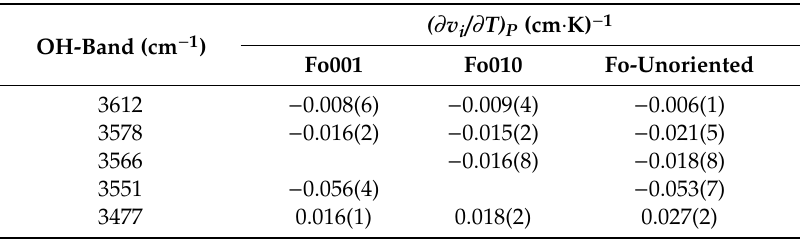
Table 1. The main OH bands with the temperature dependence ( ∂ v i / ∂ T ) P for the oriented and unoriented pieces of hydrous